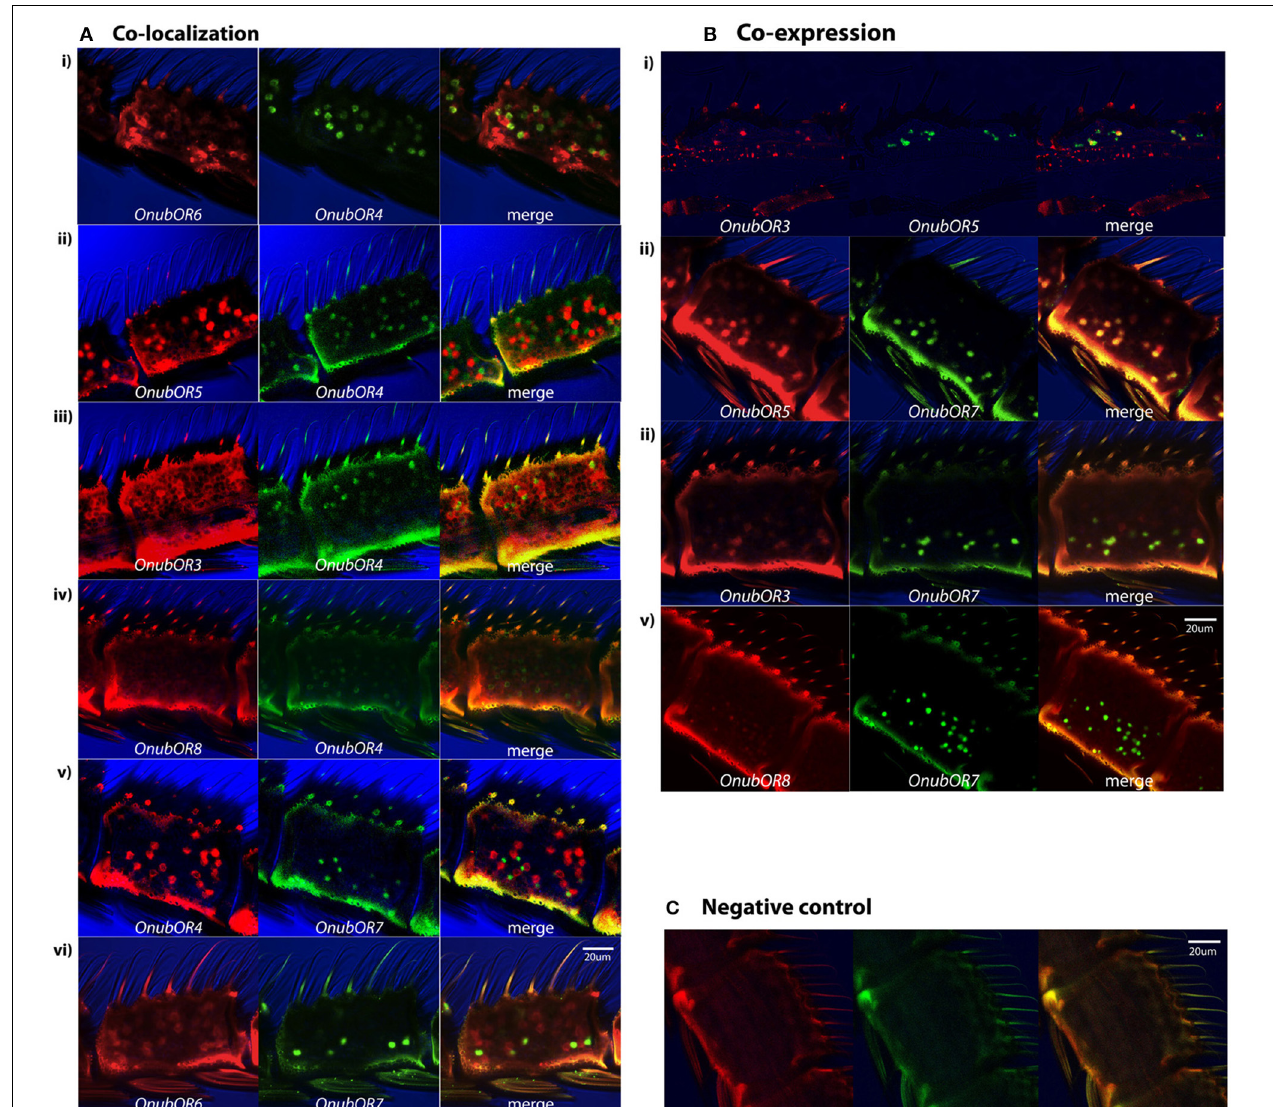
FIGURE 1 | Whole mount expression patterns of 7 O. nubilalis ’ PRs in male antennae. Two labeled antisense probes were hybridized together in each assay, each containing a different OnubOR probe for comparison. (A) Examples of OnubOR co-localization in the same sensilla. Ai–Aiv full co-localization throughout each segment, and Av,Avi partial co-localization on